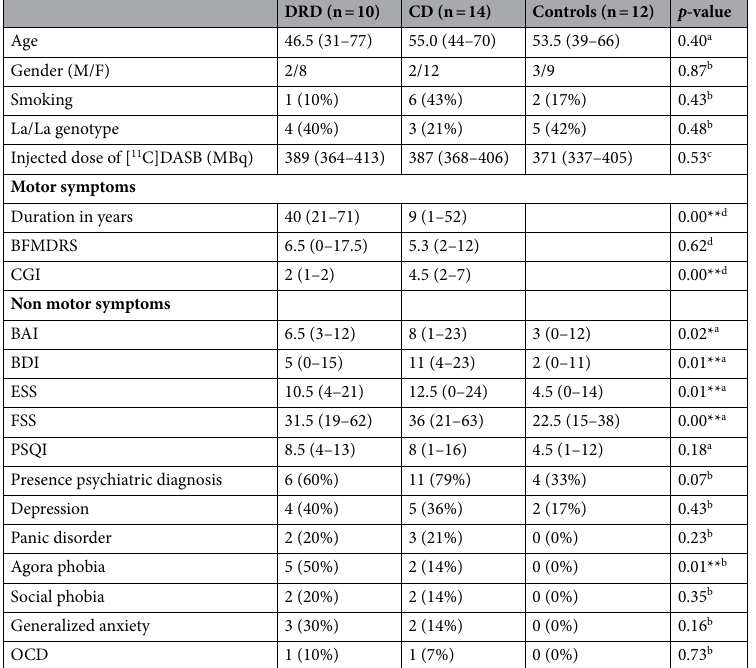
Table 1. Demographics, clinical characteristics and non-motor symptoms. Data presented as median (range), mean (95% confidence interval) or number (%). DRD dopa-responsive dystonia, CD cervical dystonia, BFMDRS Burke Fahn Marsden Dystonia Rating Scale, CGI Clinical Global Impact Scale, BAI Beck Anxiety Index, BDI Beck Depression Index, ESS Excessive Sleepiness Scale, FSS Fatigue Severity Scale, PSQI Pittsburgh Sleep Quality Index, OCD obsessive compulsive disorder. Kruskal wallis test a , fisher-freeman-halton